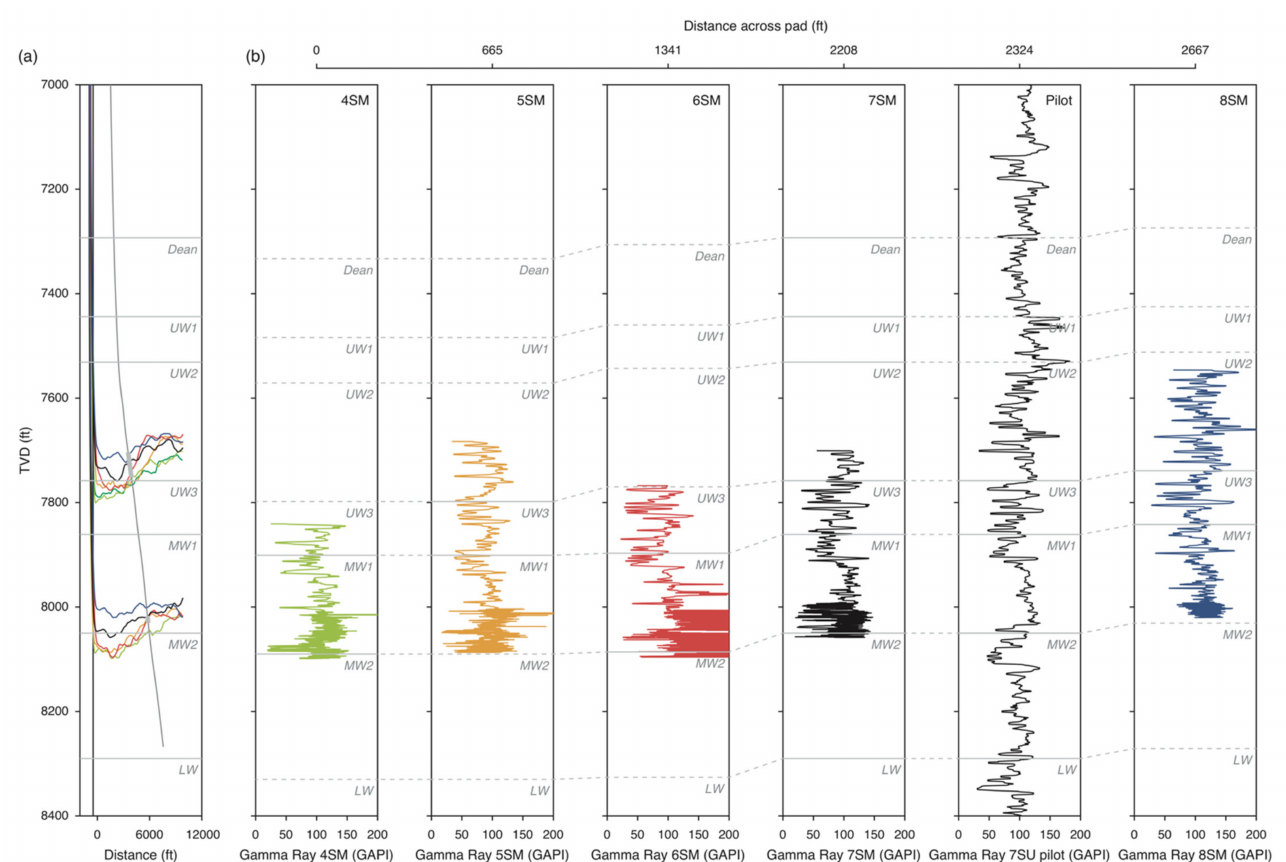
Figure A3. Stratigraphic shift for the Upper Wolfcamp (-SU) wells. ( a ) Wells in cross section, not shifted by stratigraphic depth with respect to the 7SU pilot well. ( b ) Gamma ray logs from horizontal wells 3SU–8SU and the 7SU pilot well. Solid lines indicate the location of formation tops correlated with the 7SU pilot well. Dashed lines indicate the interpreted depth of formation tops based on the stratigraphic difference with respect to the 7SU pilot